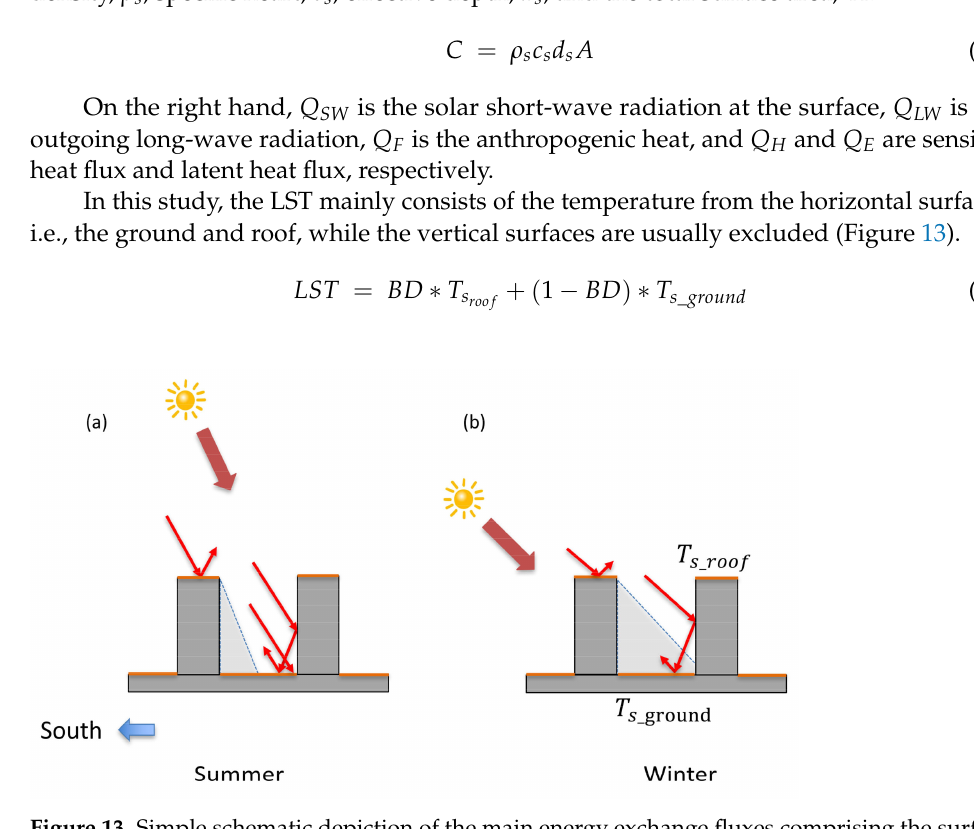
Figure 13. Simple schematic depiction of the main energy exchange fluxes comprising the surface energy balance of roof and urban canyon facets ( a ) by summer and ( b ) by winter. The structure of an urban canopy model, which simulates exchanges at street, wall, and roof surfaces representative of parts of a